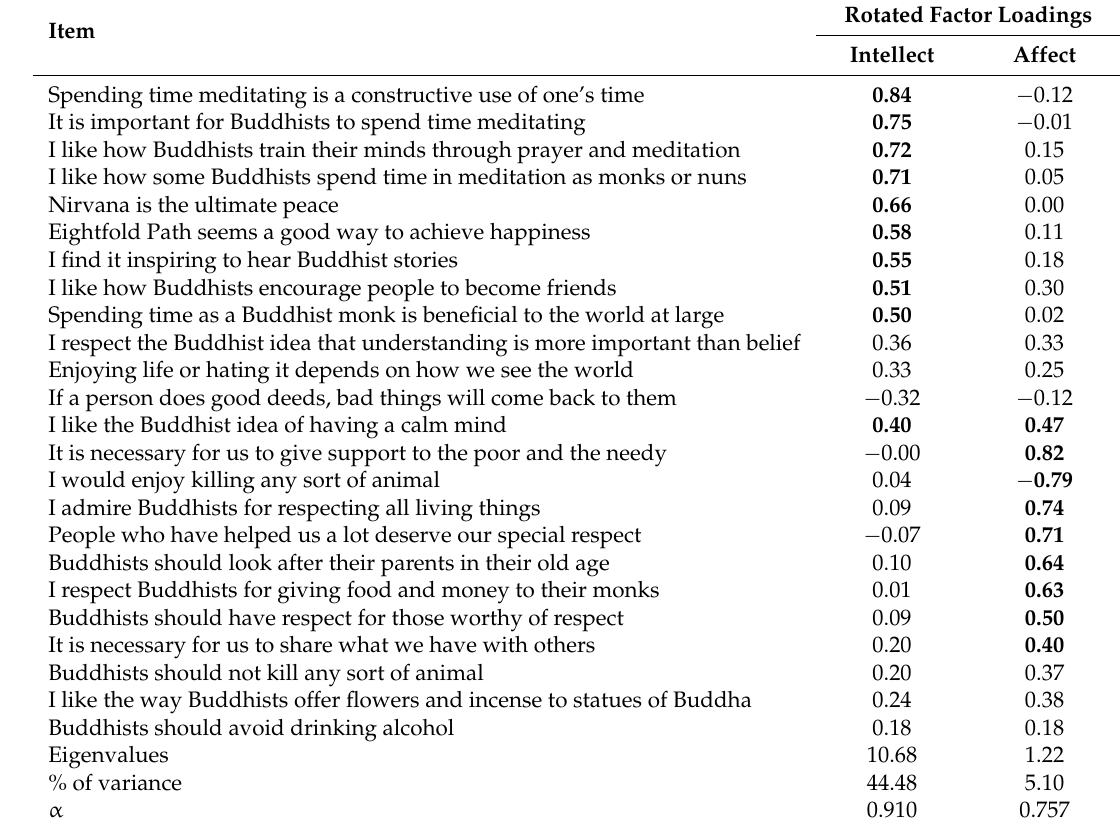
Table 3. Summary of exploratory factor analysis results for TSAB-R ( n =